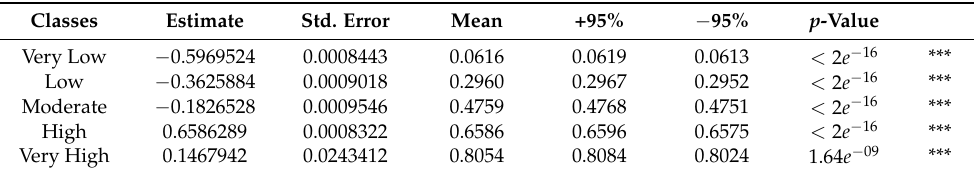
Table 7. Statistical Validation of RF-GAN using